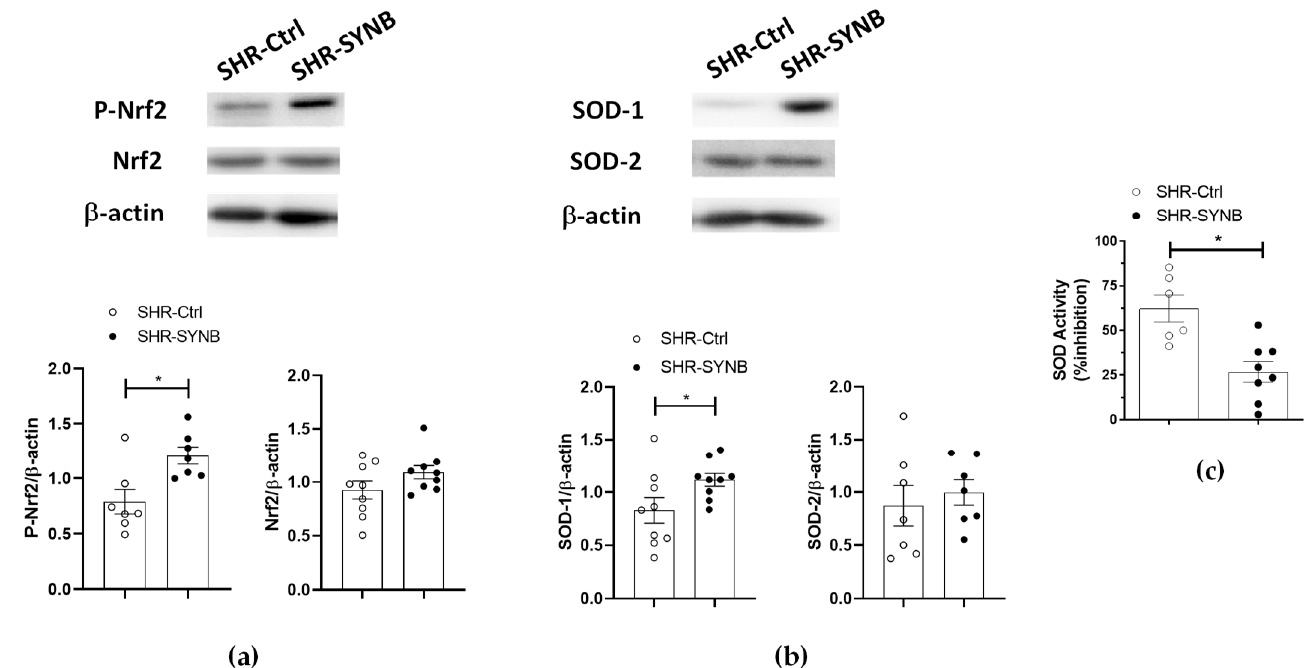
Figure 7. Western blot analysis for ( a ) total Nrf2, phosphorylated Nrf2 in Ser40 residue (P-Nrf2), and ( b ) SOD-1 and SOD-2 in mesenteric segments from SHR-Ctrl and SHR-SYNB. (7–9 isolated arterial segments from different animals in each group). Lower graphs show densitometry analyses of the protein expression. Results (mean ± S.E.M) are expressed as protein expression relative to β -actin expression. * p < 0.05 (Student’s t -test). ( c ) Superoxide dismutase activity in mesenteric segments from SHR-Ctrl and SHR-SYNB. Results (mean ± S.E.M.) are expressed as a percentage of inhibition (% inhibition). n = 6-8 segments in each group. * p < 0.05 (Student’s t -test).